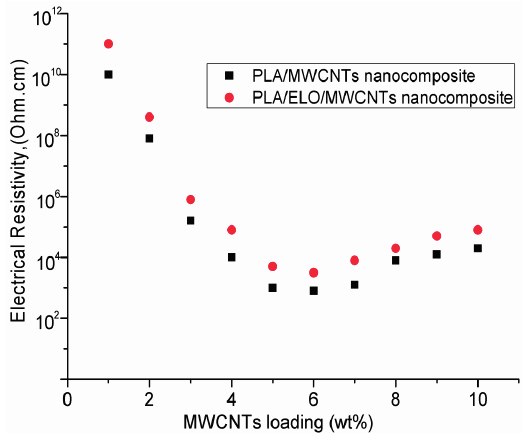
Figure 7. Electrical resistivity of MWCNTs reinforced PLA, and MWCNTs reinforced ELO plasticized PLA